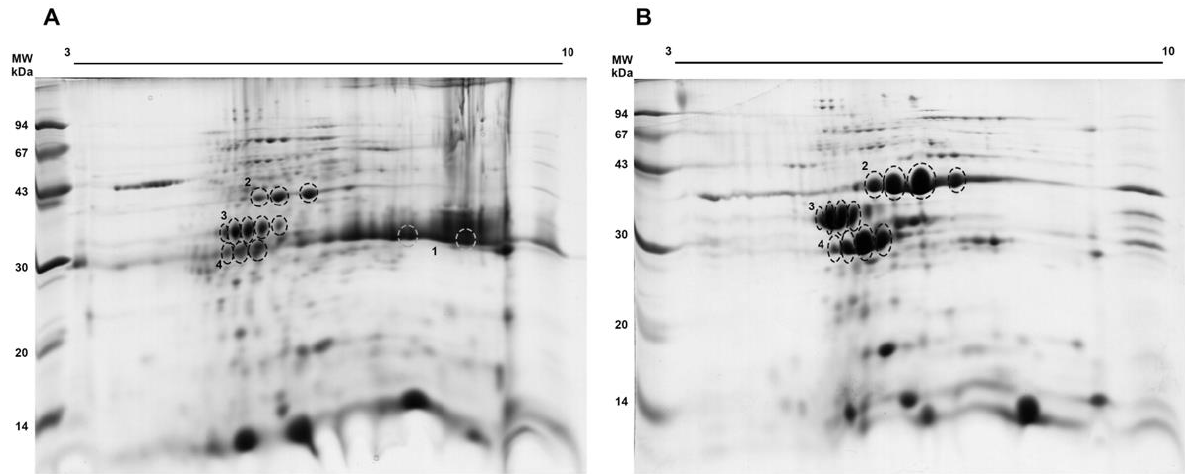
Figure 3. Proteomic profile of the EtOH 50–80% ( A ) and activity peak ( B ) fractions. The indicated spots were processed and peptides were submitted to mass spectrometry for protein identification (Table 2).